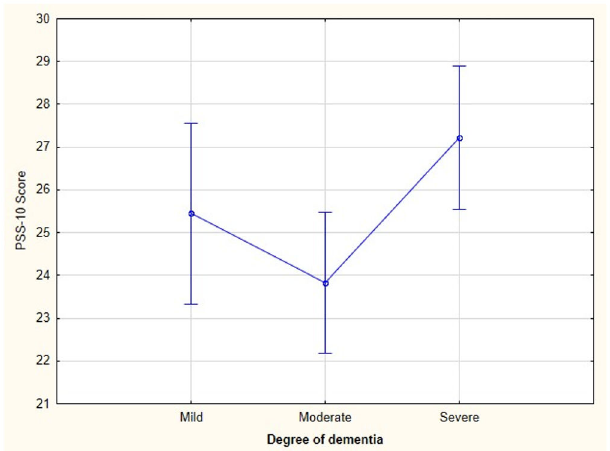
Figure 2. Distribution of sten values on the 10-item Perceived Stress Scale according to the three degrees of dementia in the charges of the caregivers studied. The current effect was F (2.82) = 4.1388 while the p -value =